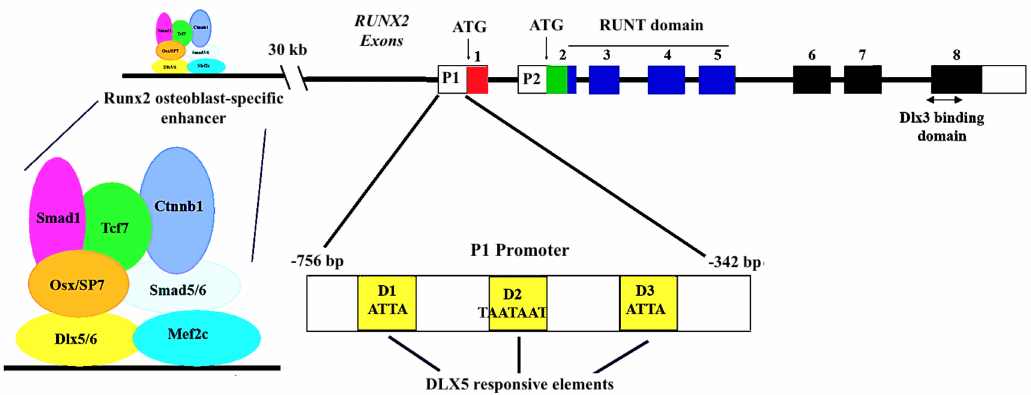
Figure 3. Genomic organization of the mouse Runx2/Cbfa1 gene locus. RUNX2 can be activated by two different promoters (P1 and P2) that give rise to two isoforms of the protein. The P1 enhancer which drives bone-specific RUNX2 expression includes three DLX5 responsive elements (D1, D2, D3). P1 alone is not sufficient to drive the expression of RUNX2 in bone, but requires an enhancer located about 30kb upstream; this enhancer binds DLX5/6 and Mef2C and other co-activator factors, such as SP7, that interact directly with DLX5. DLX5 is therefore needed both at the promoter and enhancer level for the activation of RUNX2 in